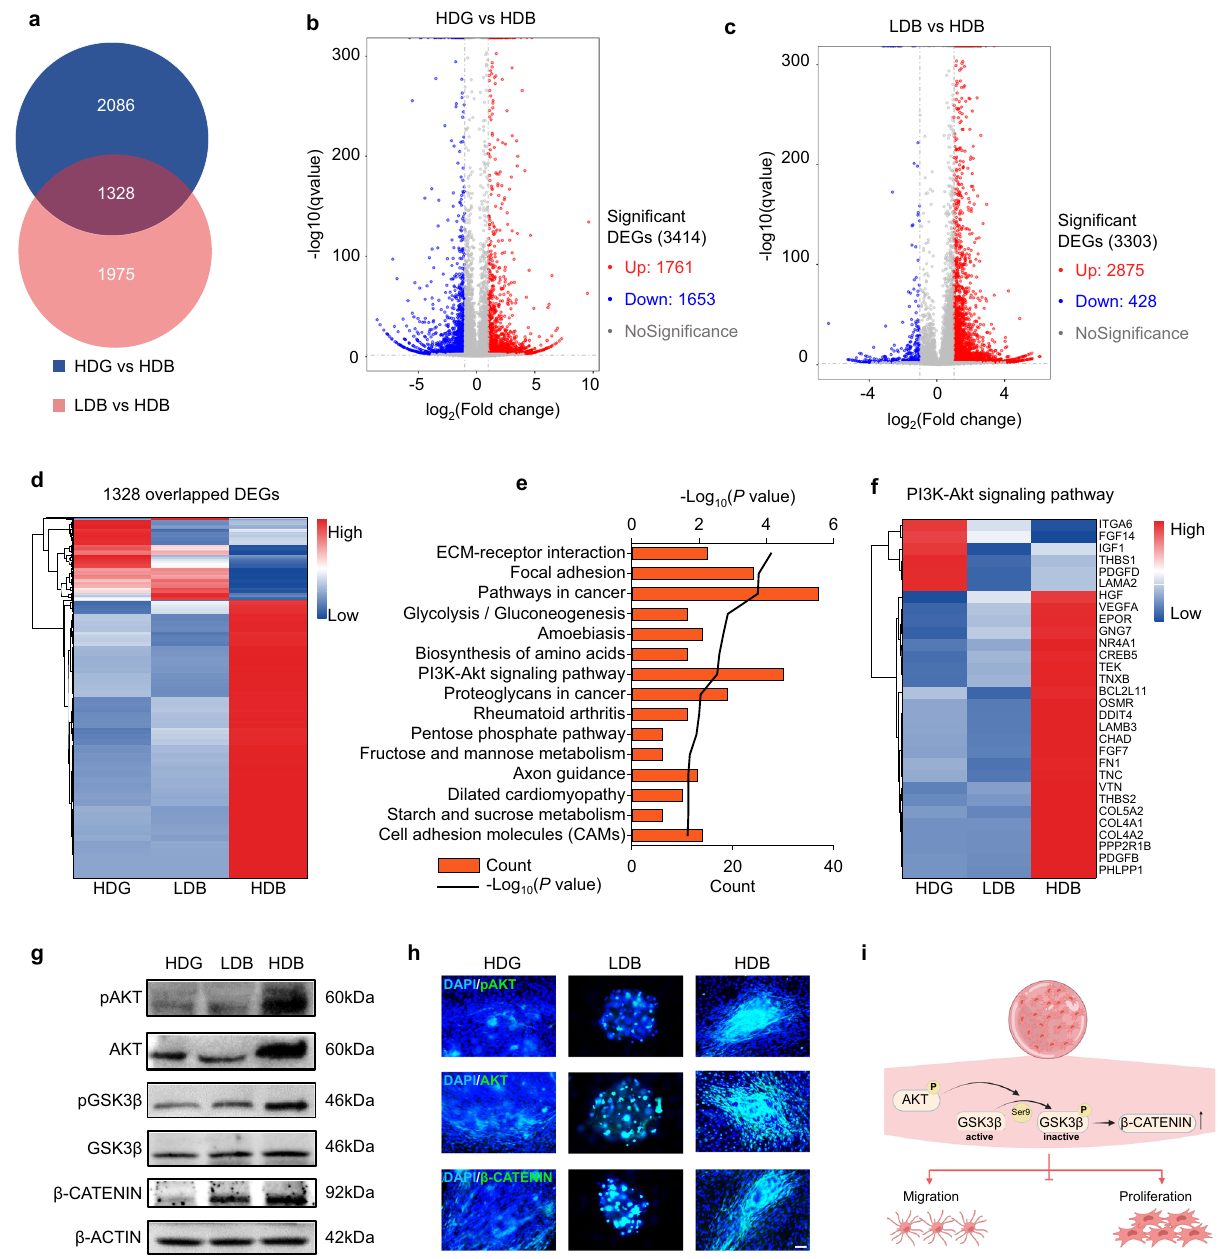
Fig. 4 | Matrigel HDB group promotes MSCs proliferation and migration through the PI3K-Akt signaling pathway and Wnt/ β -CATENIN signaling path- way. a Venn diagram showing the differentially expressed genes (DEGs) in the Matrigel HDG group and the Matrigel LDB group, both compared to the Matrigel HDBgroup. b and c VolcanodiagramofDEGsintheMatrigelHDGgroup( b )andthe MatrigelLDBgroup( c ),bothcomparedtotheMatrigelHDBgroup. d Heatmapview of the overlapped 1328 DEGs in the Matrigel HDG group and the Matrigel LDB group, both compared to the Matrigel HDB group. e KEGG pathway analysisof the